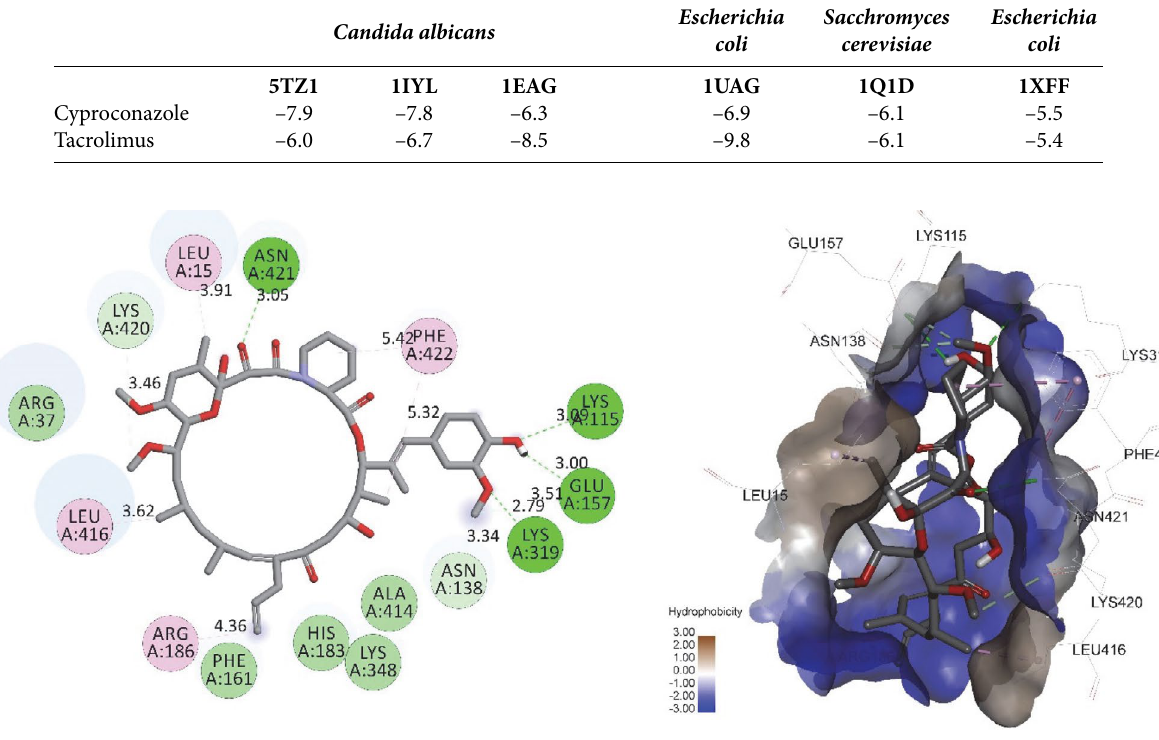
Figure 2. Visual representation (2D (left) and 3D (right)) of the tacrolimus showing bonds formation and position in the active site of UDP- N -acet- ylmuramoyl- L -alanine: D -glutamate ligase (MurD) 1UAG. Pale green – van der Waals interaction, green – classical conventional hydrogen bond, light green – non classical carbon hydrogen bond, pink – hydrophobic alkyl and π-alkyl